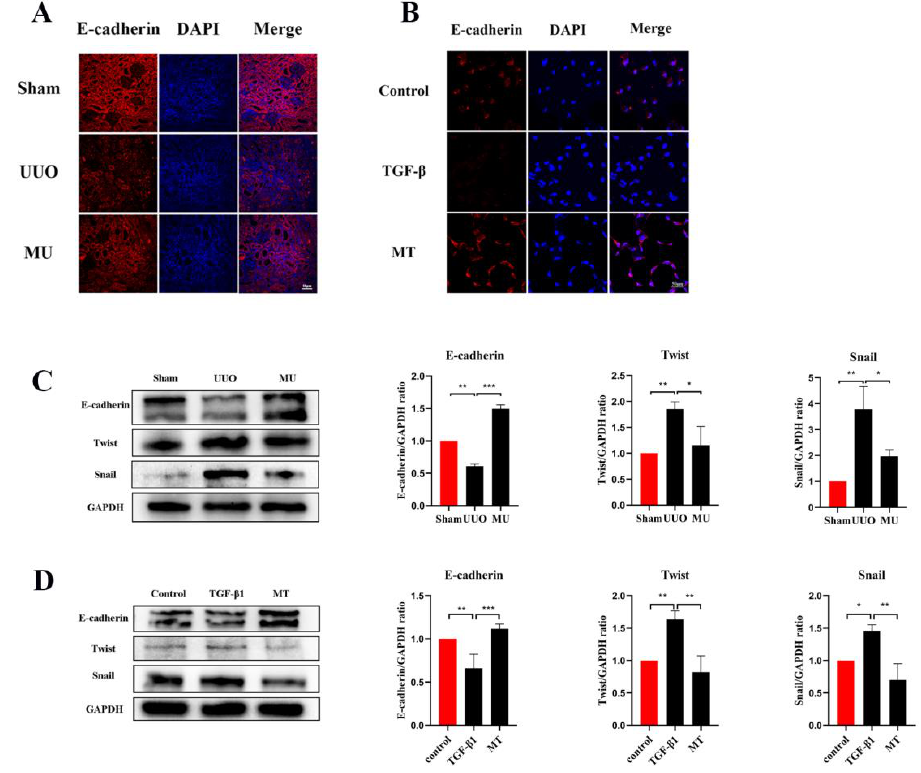
Figure 4. MK-2206 inhibited the EMT process in UUO mice and TGF- β 1-induced HK-2 cells. ( A , B ) Immunofluorescence staining of E-cadherin in renal tissue and HK-2 cells (scale bar: 50 μ m). ( C , D ) Western blot analysis of E-cadherin and transcription factors (Snail and Twist). Protein levels were normalized with GADPH. * p < 0.05, ** p < 0.01, *** p < 0.001. MU: UUO + MK-2206, MT: TGF- β 1 + MK-2206.